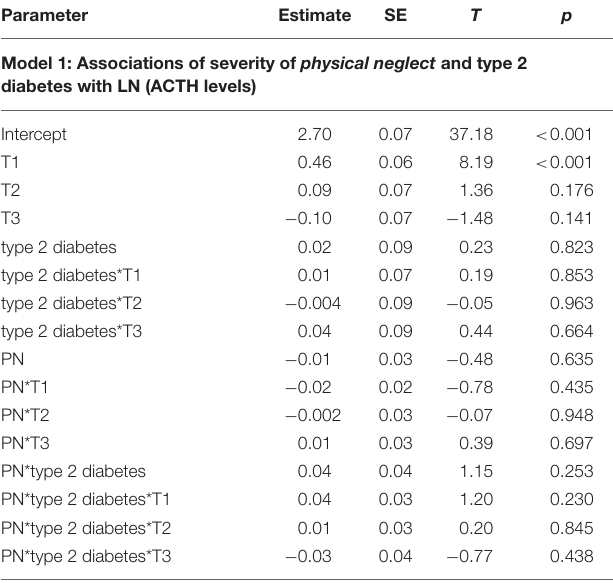
Model 2: Associations of severity of emotional neglect and type 2 diabetes with LN (ACTH levels)